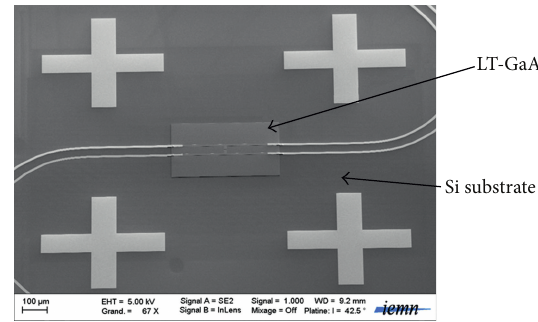
Figure 3: The rectangle in the center is a thin LT-GaAs layer on the HR-Si substrate. On the layer the dipole antenna and in each corner the alignment marks are processed. Wires on the substrate are connected to the dipole on the